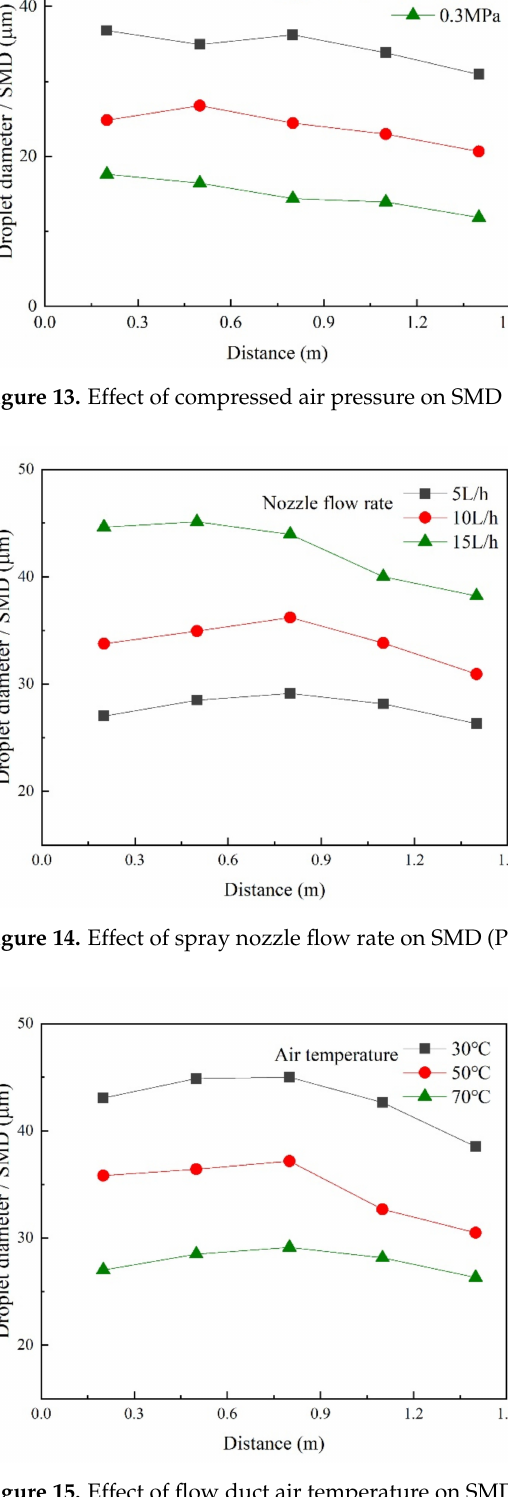
Figure 15. Effect of flow duct air temperature on SMD (P = 0.1 MPa, Q = 5